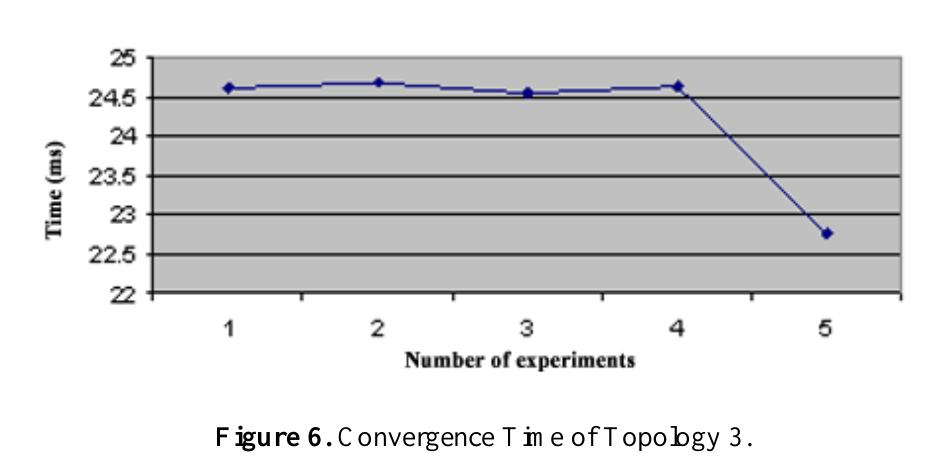
Figure 5. Convergence Time of Topology 2.